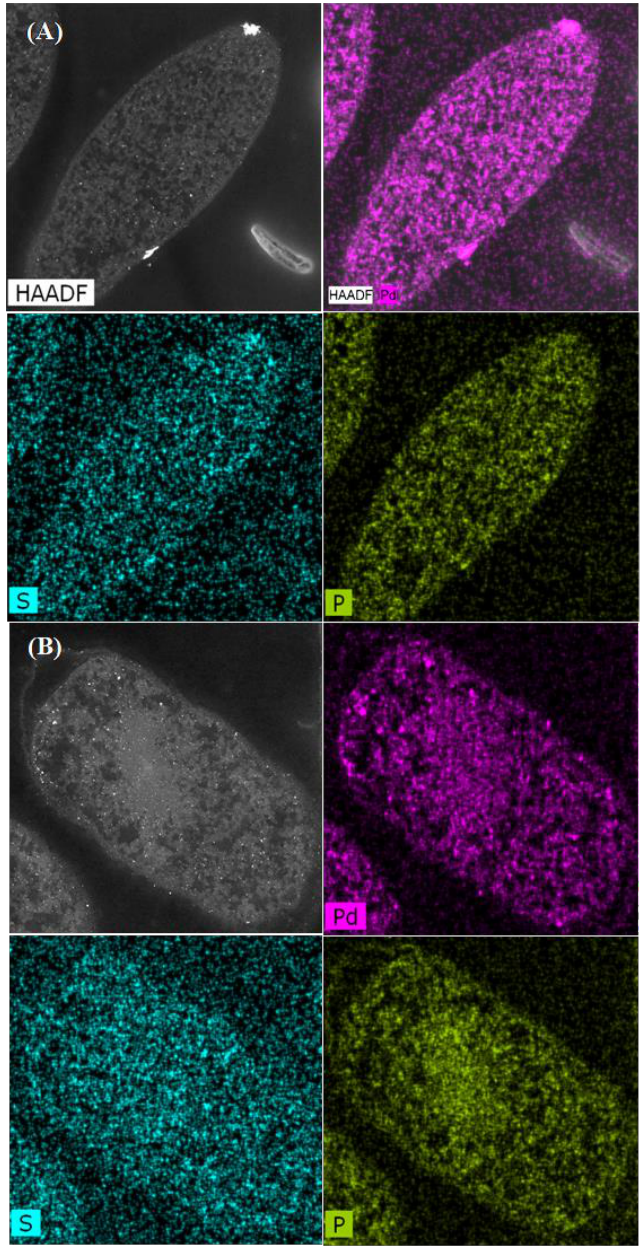
Figure 3. Elemental mapping showing distribution of Pd, P, and S in untreated cells of E. coli MC4100 ( A ) and cells treated with MW for 30 sec ( B ). The Manders overlap coefficients were higher than 0.9 for Pd/P and Pd/S in control and MW-treated cells.